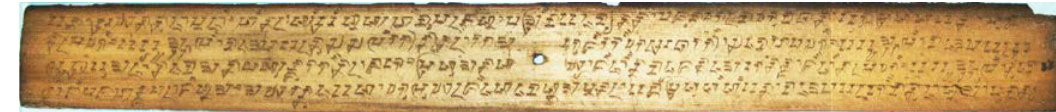
Figure 12. Balinese manuscript with binarized ground truth image.